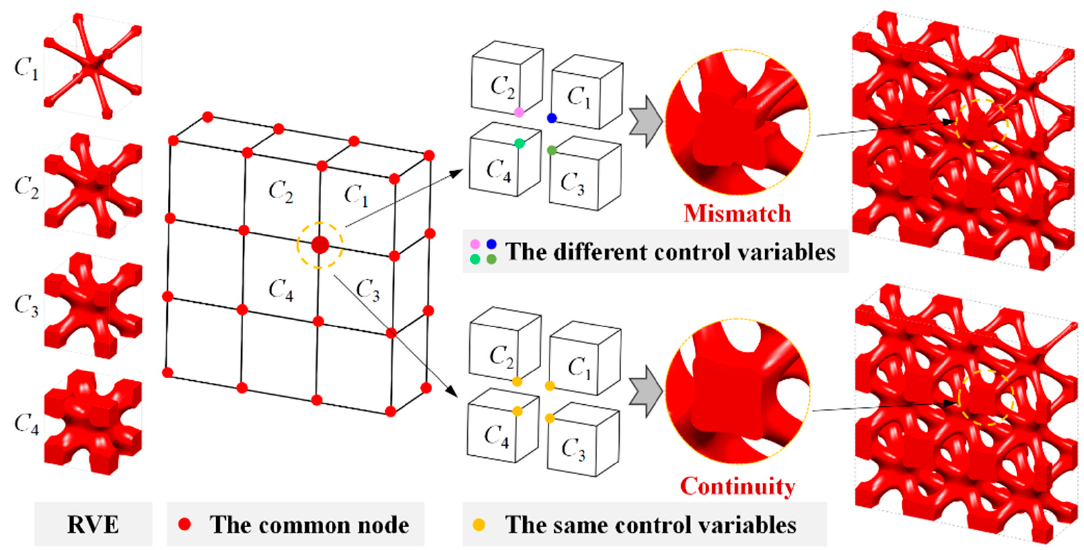
Figure 5. Illustration of the continuity of geometric boundaries.